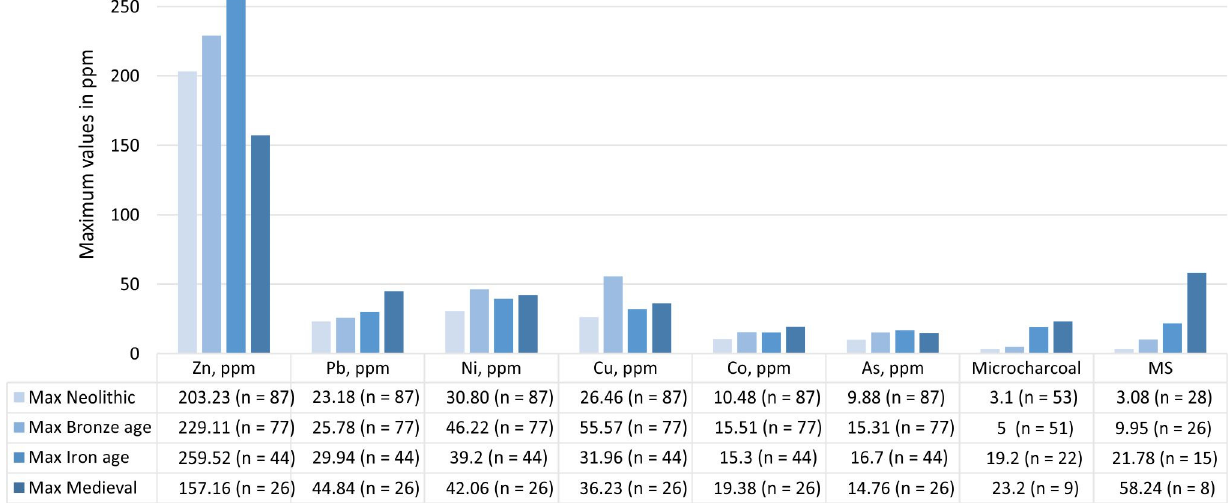
Figure 3. The maximum values of element concentrations in the Kamyshovoe Lake sediments according to historical period.